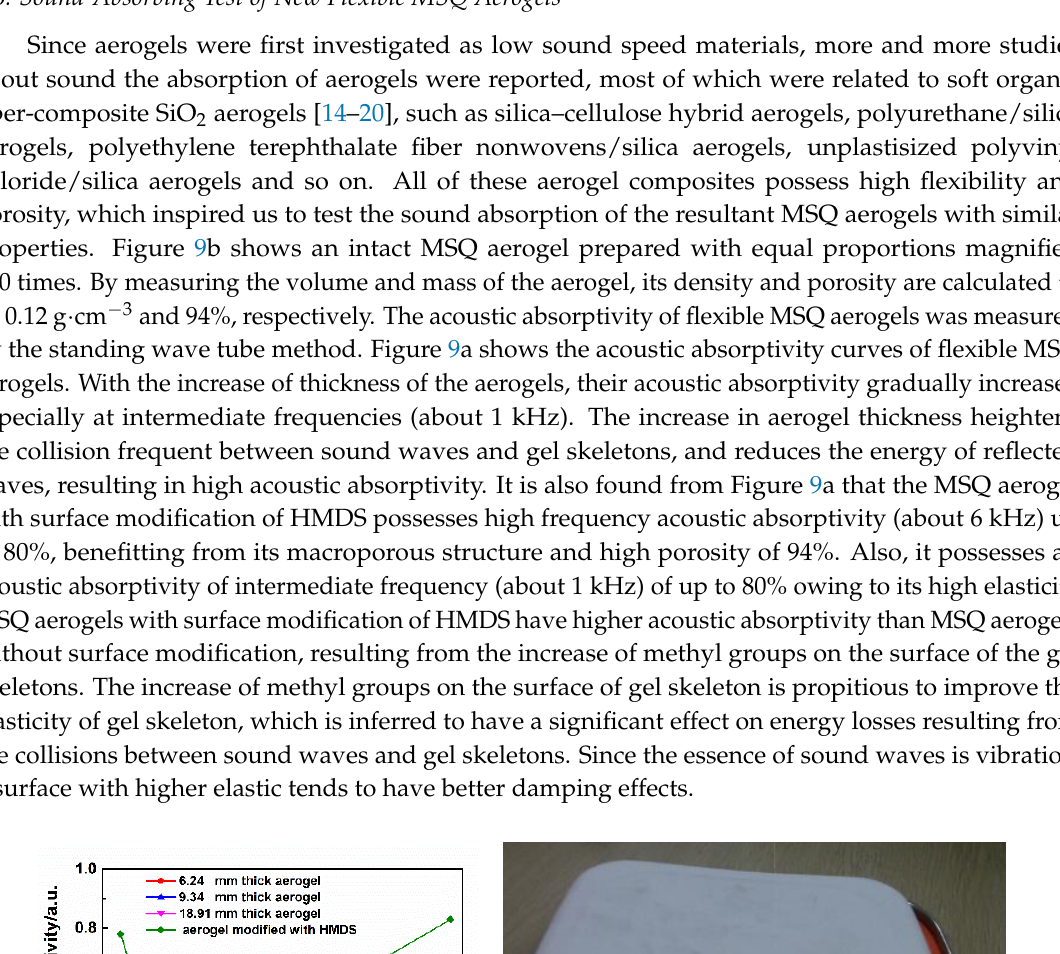
Figure 8. Contact angle images of flexible MSQ aerogels with different surface modifications: ( a ) HMDSO; ( b ) HMDS; ( c ) HMDSO + HMDS (volume ratio is 1:1).